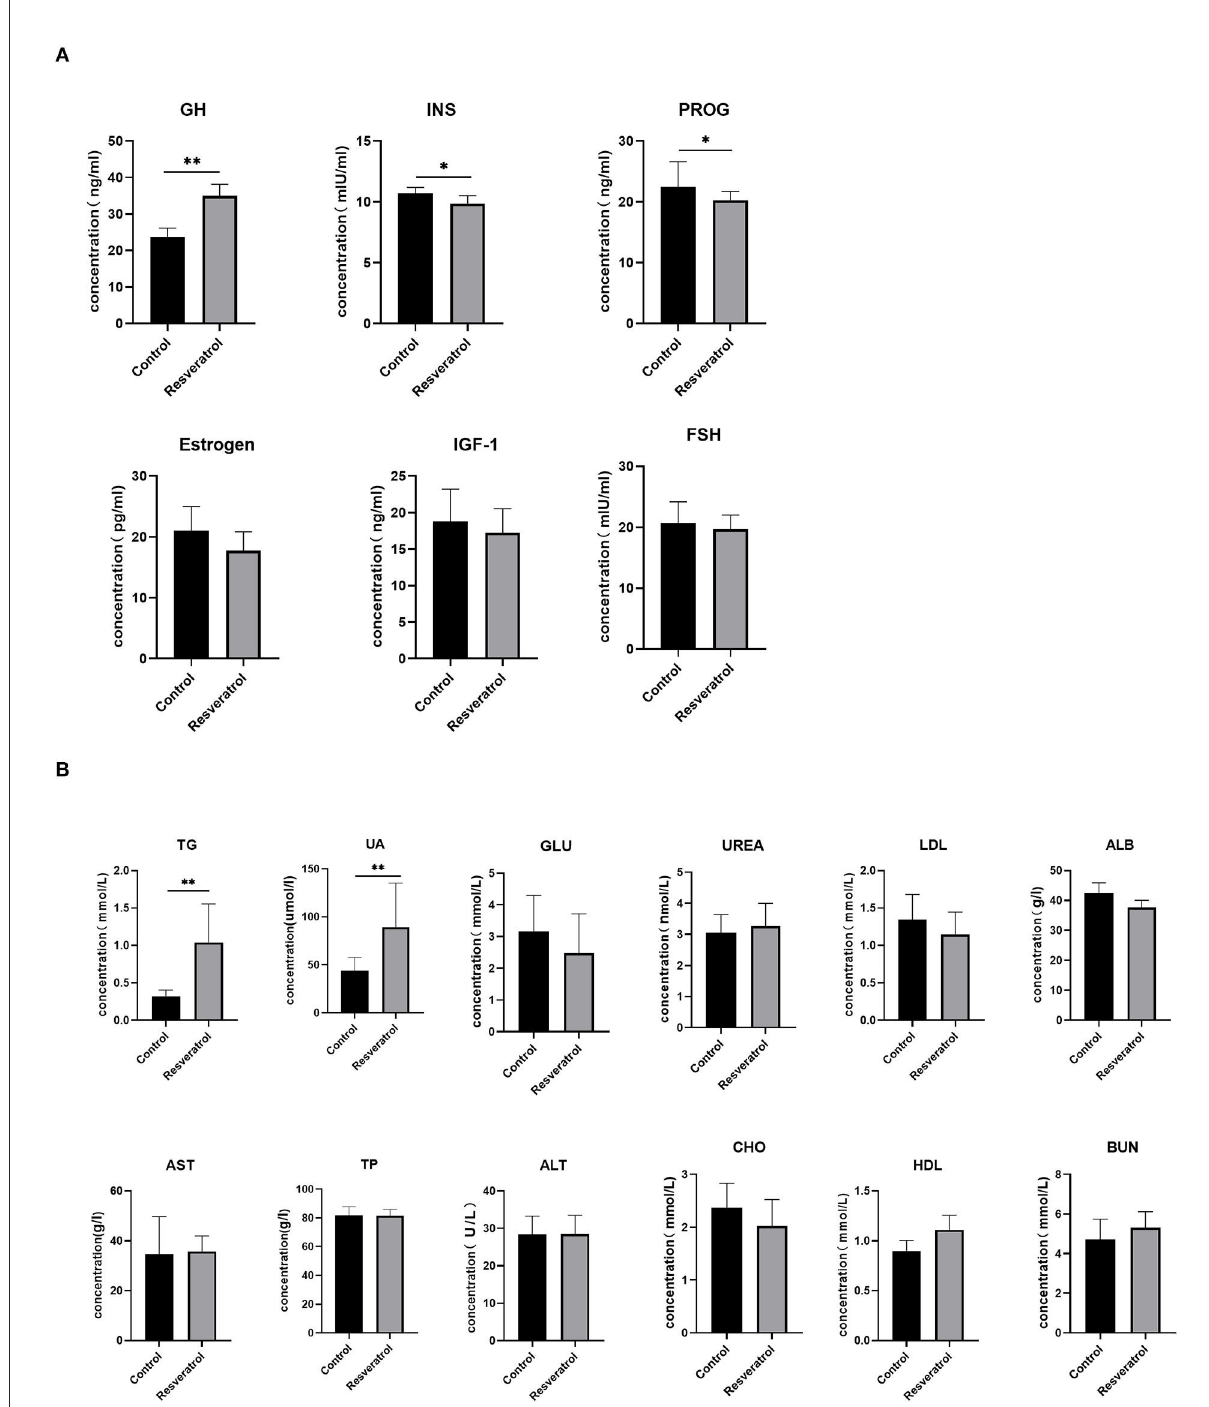
FIGURE2 Effect of dietary resveratrol supplementation for the second phase during gestation and lactation on blood hormonal and biochemical markers. (A) Blood hormones in sows during 14 days of lactation. (B) Biochemical indices of sows during 14 days of lactation. Data were expressed as means ± SEM of at least three independent experiments. GH, growth hormone; INS, insulin; PROG, progesterone; IGF-1, insulin-like growth factor-1; FSH, follicle stimulating hormone; TG, triglycerides; UA, uric acid; GLU, glucose; UREA, urea; LDL, low-density lipoprotein; ALB, albumin; AST, aspartate aminotransferase; TP, total protein; ALT, alanine aminotransferase; CHO, cholesterol; HDL, high-density lipoprotein; BUN, urea nitrogen. * p < 0.05, ** p <